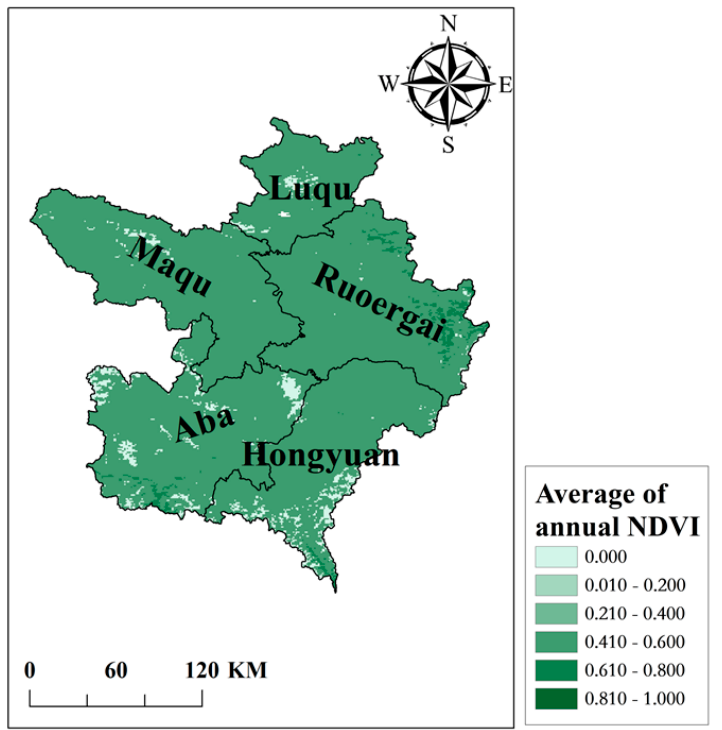
Figure 6. Spatial distribution of the mean NDVI values in the RWA from 1982 to 2018. The total area in this region was 59,889 pixels, of which the area with values equal to 0 was 2339 pixels, accounting for 0.039% of the area. The area distributed from 0.010 to 0.200 was 18 pixels. The area distributed from 0.210 to 0.400 was 5447 pixels, accounting for 0.091% of the total area. The area distributed at the interval from 0.410 to 0.600 was 51,143 pixels, ac- counting for 85% of total accounts. The area in the range of NDVI values of 0.610 to 0.800 was 942 pixels, accounting for 0.0158%.